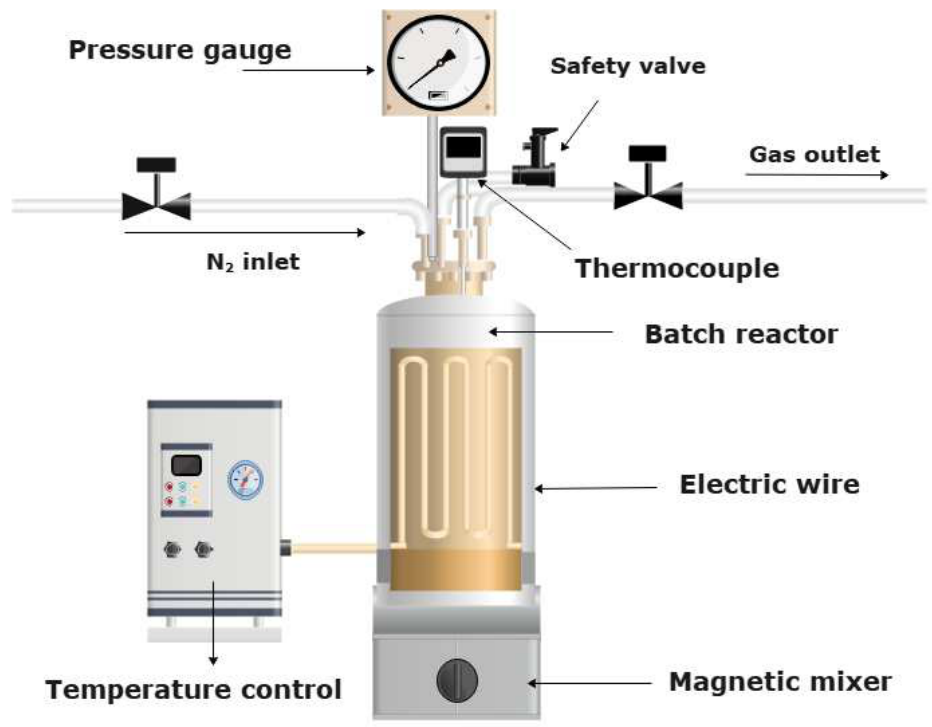
Figure 1. SCW batch reactor system for the chemical degradation of PVC waste in SCW.